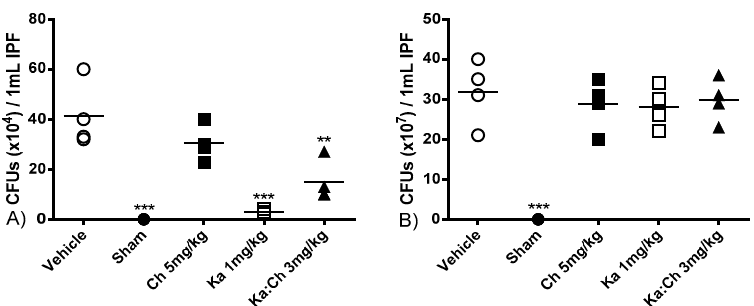
Figure 6. The effects of kaempferol and chrysin individual and combination treatments on bacterial colony forming units (CFUs) growth number/mL of IPF, at ( A ) 6 and ( B ) 24 h post-CLP. Abdominal swabs plated on nutrient agar and incubated for 24 h prior to CFU count. Data are presented as mean CFUs/mL. ** p ≤ 0.01 and *** p ≤ 0.001 versus CLP/vehicle of the same time point (Student’s t -test).